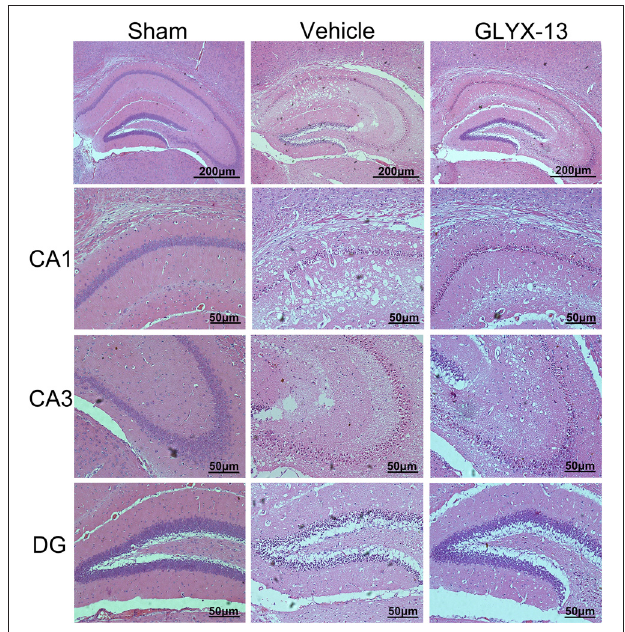
FIGURE 3 | Administration of GLYX-13 attenuating post-ischemic neuronal injury. Representative hematoxylin and eosin (HE) staining coronal brain sections showed the hippocampal CA1, CA3, dentate gyrus (DG) areas,